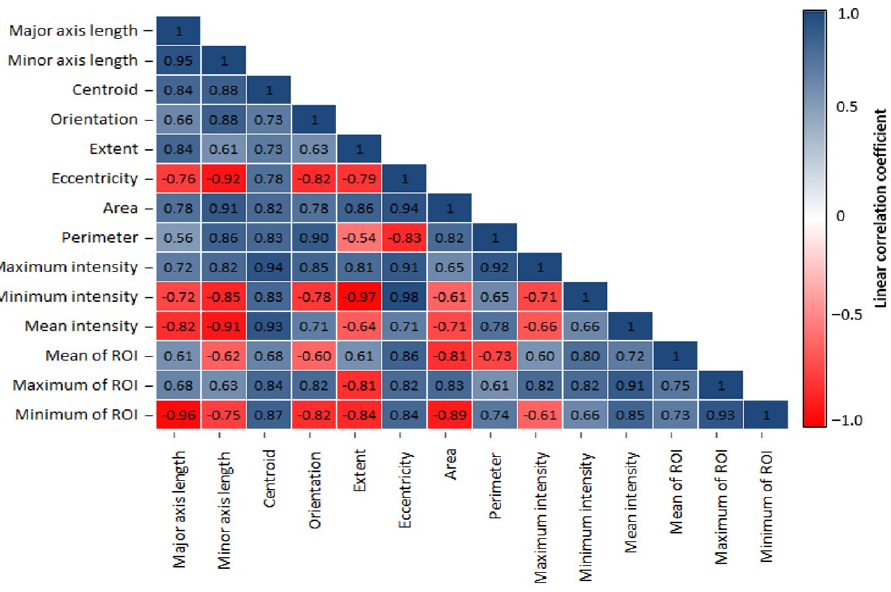
Figure 4. Linear correlation coefficients between all image parameters of pineapple images.